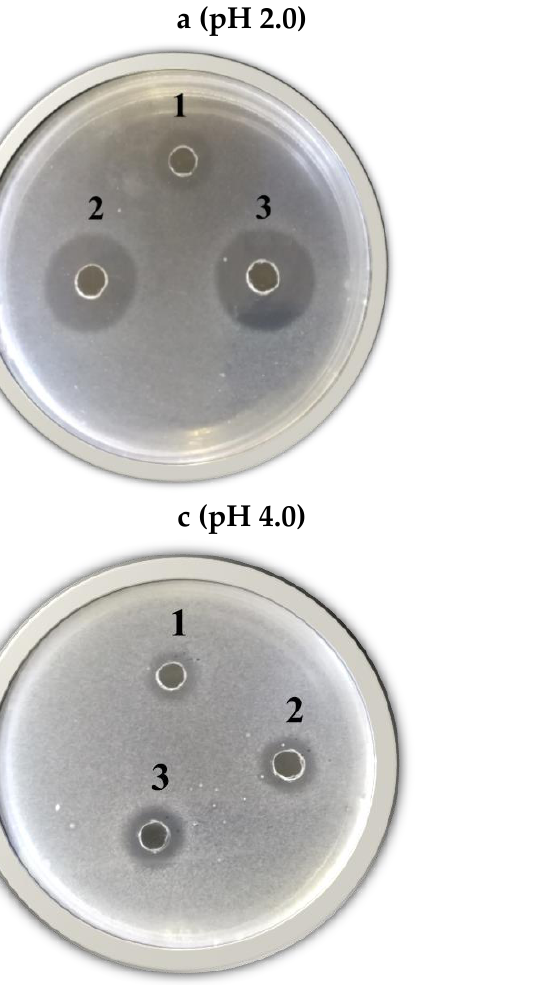
Figure 2. Growth inhibition activity of the crude biopreservatives from Candida pyralidae Y1117 (1), Pichia kluyveri Y1125 (2), and Pichia kluyveri Y1164 (3) against Dekkera anomala on grape pomace extract agar at di ff erent pH levels: ( a ) pH 2.0, ( b ) pH 3.0, ( c ) pH 4.0, and ( d ) pH 5.0.